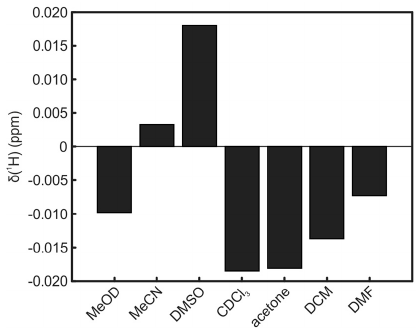
Figure 5. Chemical shift of TMS relative to TSP for all organic solvents.